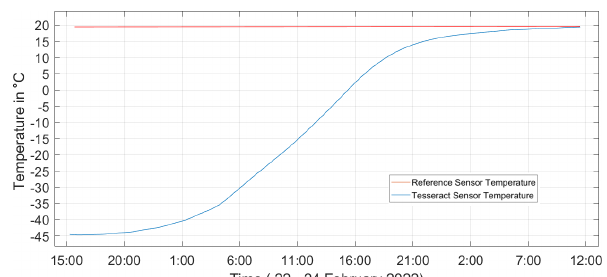
Figure 10. The temperature of the Tesseract sensor (blue) is mea- sured using a platinum RTD as the dry ice sublimates. The temper- ature of the reference magnetometer (red) was also monitored and found to vary by less than 0.1 ◦ C over the course of the test.